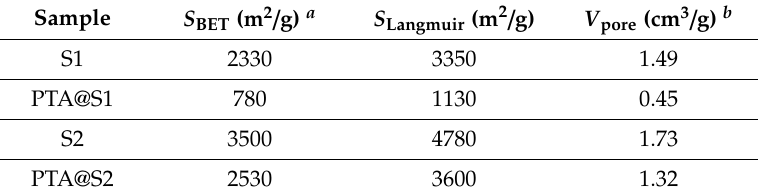
Table 1. The surface area and pore volume for S1, PTA@S1, S2 and PTA@S2.